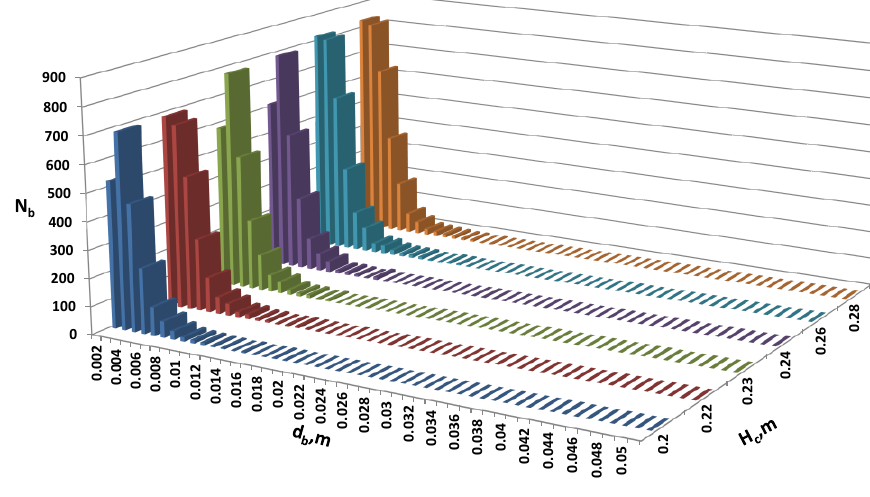
Figure 13. Variation of BSD with H c at U = 0.025 ms − 1 .